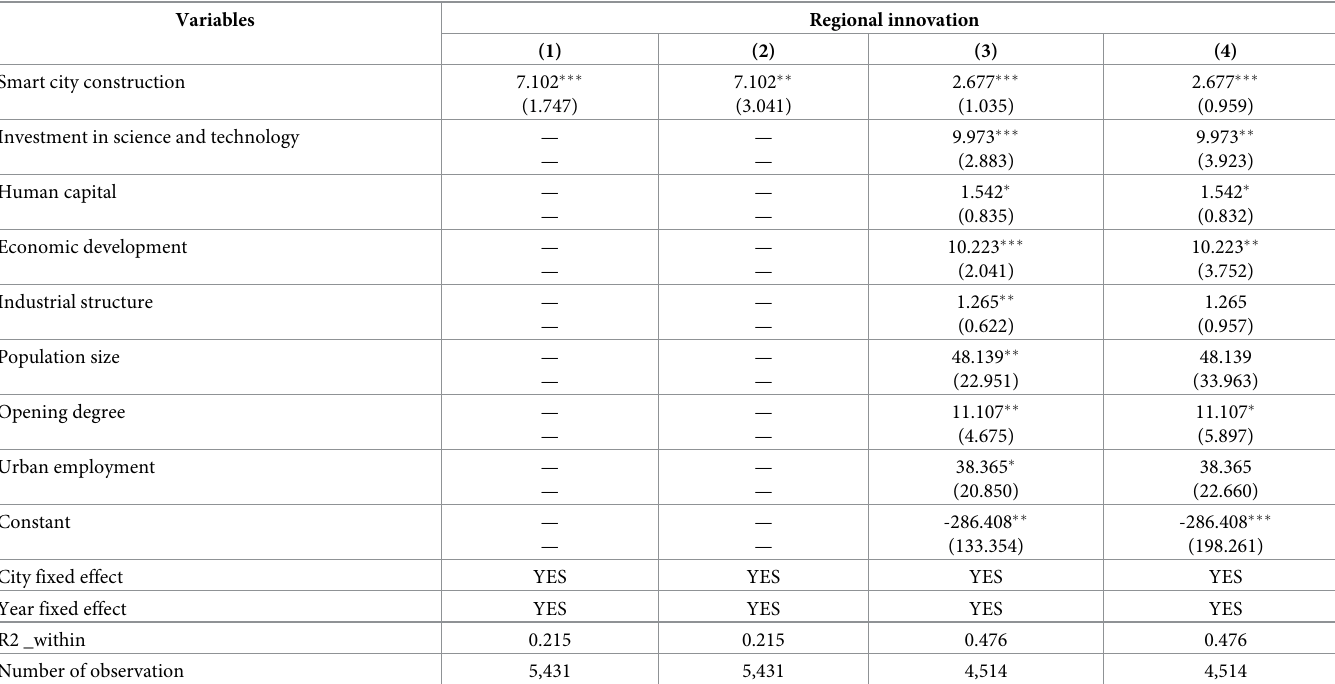
Table 2. The baseline estimation